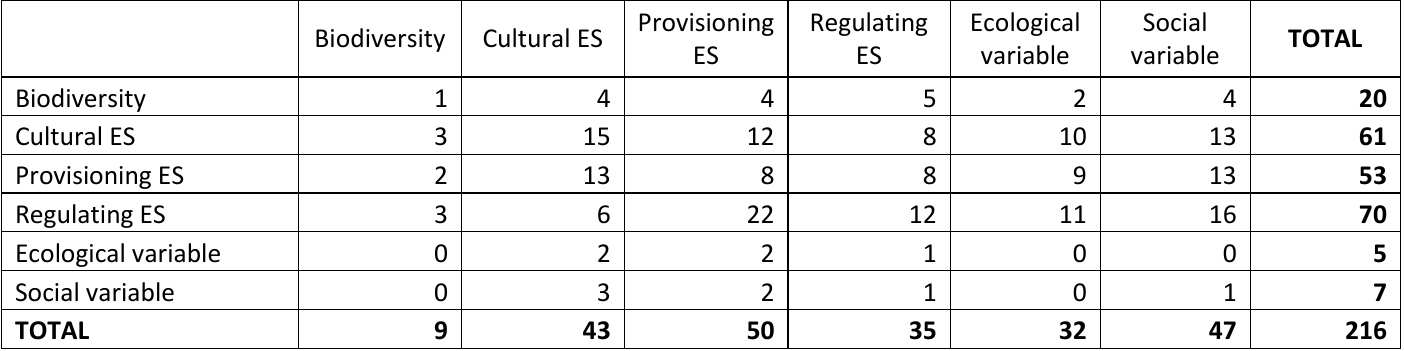
Table A3.1: Total number of influence relationships emitted by category in column and received by category in line, extracted from the global influence matrix (Appendix 2).